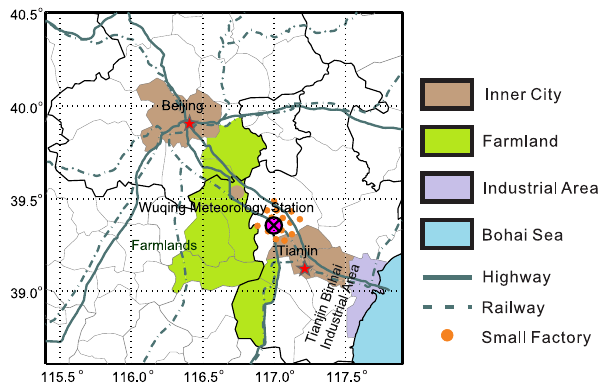
Fig. 1. Location of the campaign site (Wuqing Meteorology Sta-